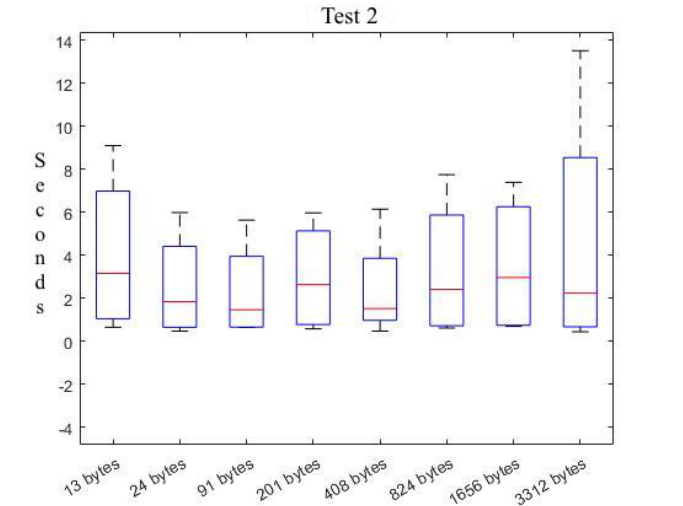
Figure 10. Summary of response